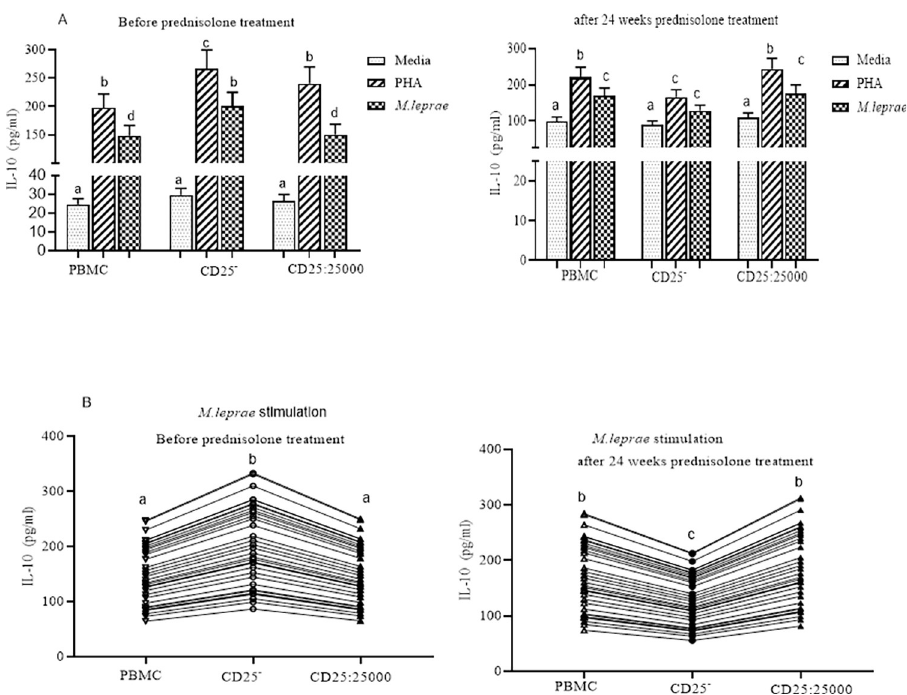
Fig 6. The effect of depletion of CD25 + cells on IL-10 secretion by PBMC from ENL participants (n = 30): (Fig 6A) IL- 10 response to PHA and M . leprae WCS stimulation before and after 24 weeks of prednisolone treatment of individuals with ENL; (Fig 6B) IL-10 response to M . leprae WCS stimulation in control PBMCs, CD25 + depleted PBMCs and autologous CD25 + re-added PBMCs from individuals with ENL before and after 24 weeks of prednisolone treatment. Each bar and line graphs show mean ± 95% confidence interval (CI). Any pair of different letters shows that the mean of IL-10 production of the two groups are statistically significantly different at p = 0.05 and any pair of similar letters indicates that the mean of IL-10 production the two groups are not statistically significantly different at P � 0.05 and 95% CI. AIM-V medium only was used in the assay as the negative control and PHA used as positive